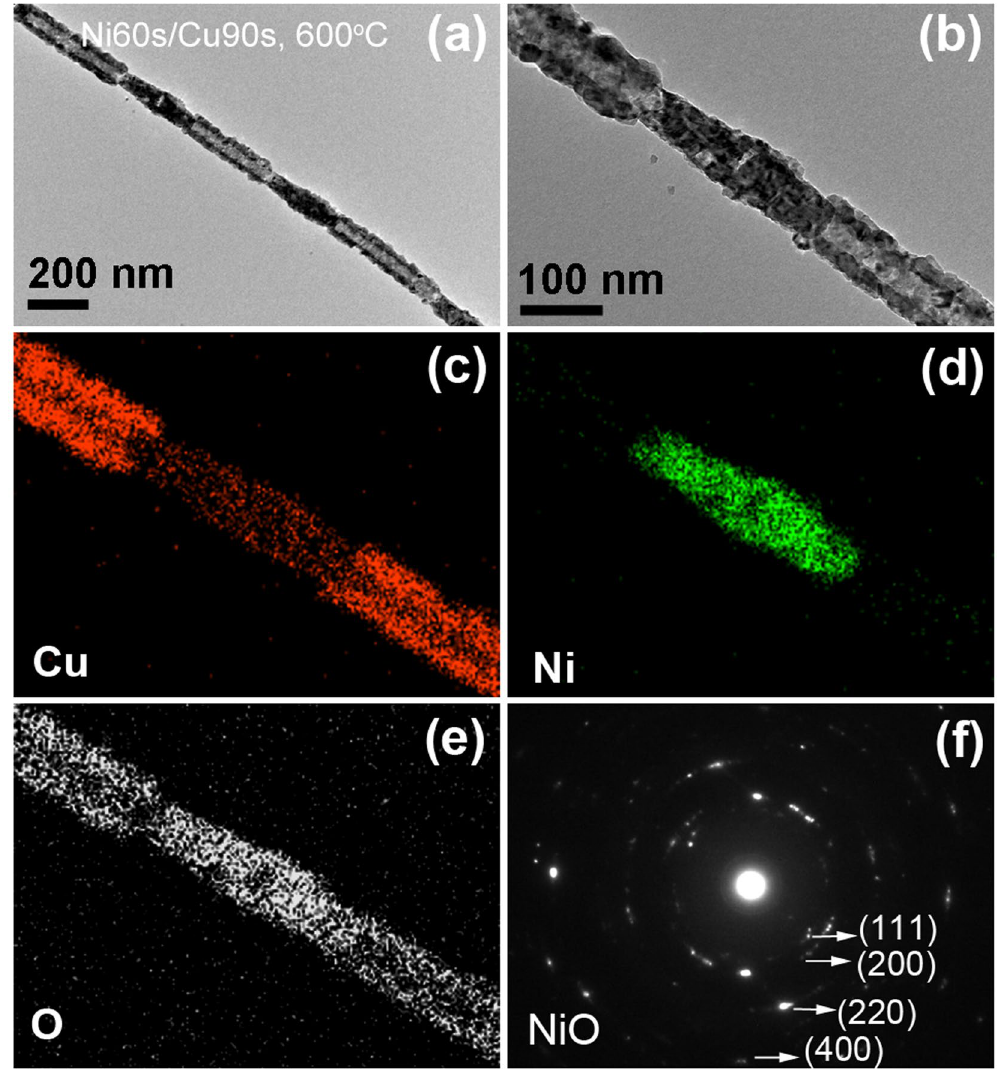
Figure 8. The Ni60s/Cu90s sample after annealing at 600 °C for 2 h. ( a ) TEM image of the annealed single nanowire; ( b – e ) magnified TEM image and the corresponding EDS elements mapping images; ( f ) SAED pattern of the NiO